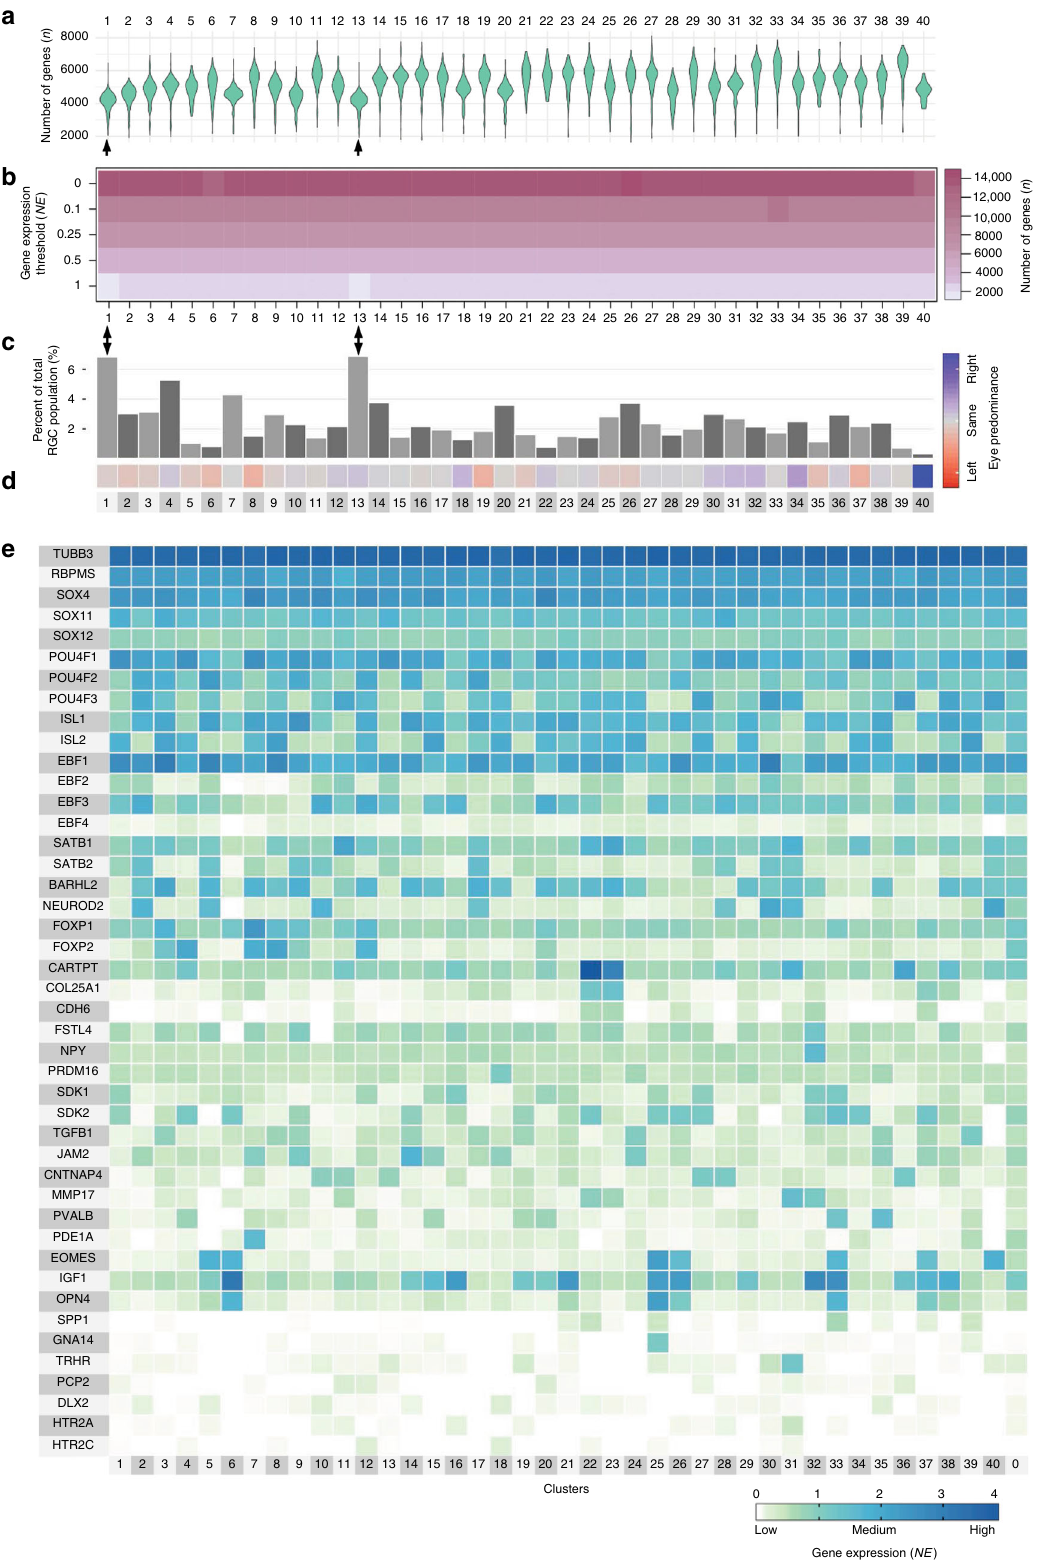
Fig. 3 Global properties of subtype transcriptome and the known RGC markers. a Violin graph showing average number and distribution of genes expressed per cluster as probability density. b Proportion of genes number expressed across different ranges, from low to highly expressed genes. c , d Percent of RGCs per cluster ( c ) and color-coded predominance of the cluster in left (red) or right (blue) eye ( d ). Subtypes 1 and 13 indicated by arrowheads in ( a – c ) are the lighter intensity boxes in ( b ) at the 1 NE threshold. e Heatmap of the known RGC markers shows that Tubb3, RBPMS, and Sox4 have the most homogenous expression across all RGC subtypes. Most of the known RGC markers show strong expression in more than one